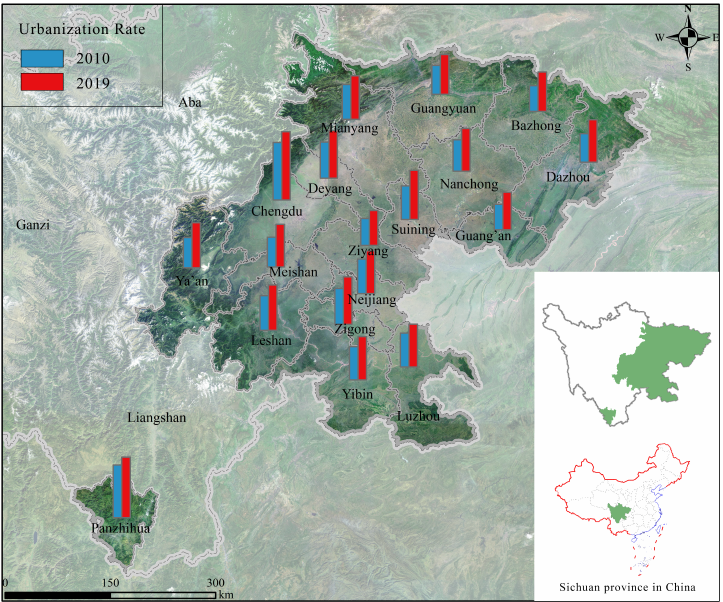
Figure 4 Figure 4. Location and urbanization rate of the study area.